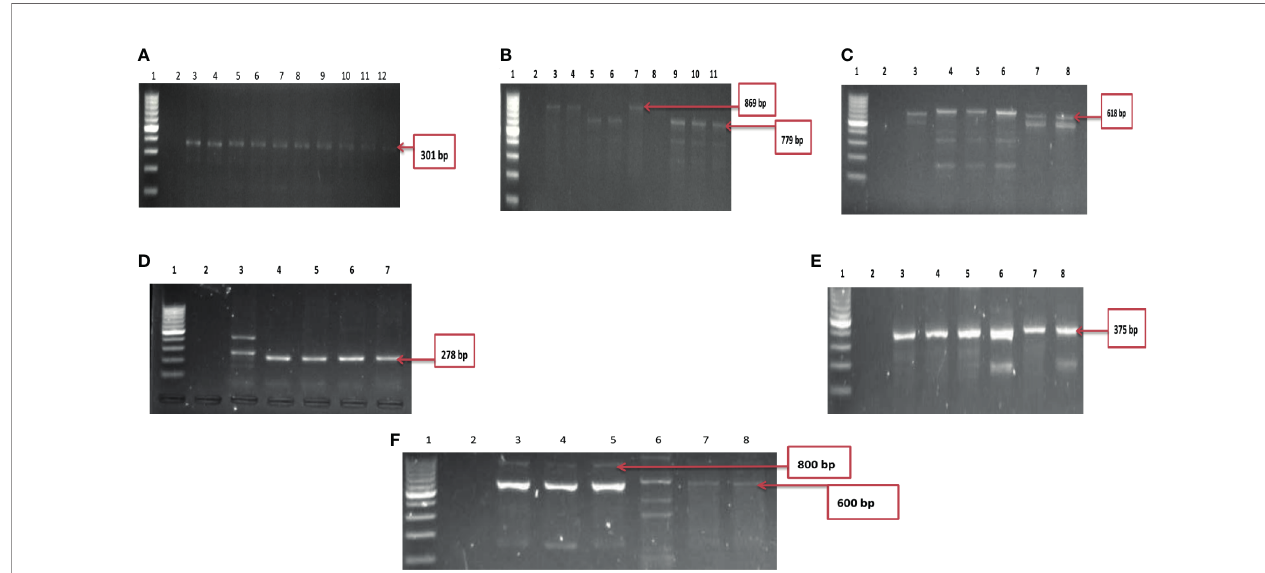
FIGURE 4 | (A) Gel electrophoresis showing the ctx gene among isolates belonging to V. mimicus. Lane 1: Molecular Marker (100 bp), lane 2: Negative control; Lane 3- 12: positive isolates of ctx gene (301 bp). (B) Gel multiplex electrophoresis showing the ompU and toxR genes among isolates belonging to V. mimicus. Lane 1: Molecular Marker (100 bp), lane 2: Negative control; Lane 3, 4, 7 and 8: positive isolates of ompU gene (869 bp). Lane 5, 6, 9-11: positive isolates of toxR gene (779 bp). (C) Gel electrophoresis showing the VPI gene among isolates belonging to V. mimicus. Lane 1: Molecular Marker (100 bp), lane 2: Negative control; Lane 3-8: positive isolates of VPI gene (618 bp). (D) Gel electrophoresis showing the vcgC and vcgE gene among isolates belonging to V. vulni fi cus. Lane 1: Molecular Marker (100 bp), lane 2: Negative control; Lane 3-7: positive isolates of vcgC and vcgE gene (278 bp). (E) Gel electrophoresis showing the stn gene among isolates belonging to V. fl uvialis. Lane 1: Molecular Marker (100 bp), lane 2: Negative control; Lane 3-8: positive isolates of stn gene (375 bp). (F) Gel multiplex electrophoresis showing the vfh and hupO gene among isolates belonging to V. fl uvialis. Lane 1: Molecular Marker (100 bp), lane 2: Negative control; Lane 3-7: positive isolates of vfh gene (800 bp). Lane 8: positive isolates of hupO gene (600